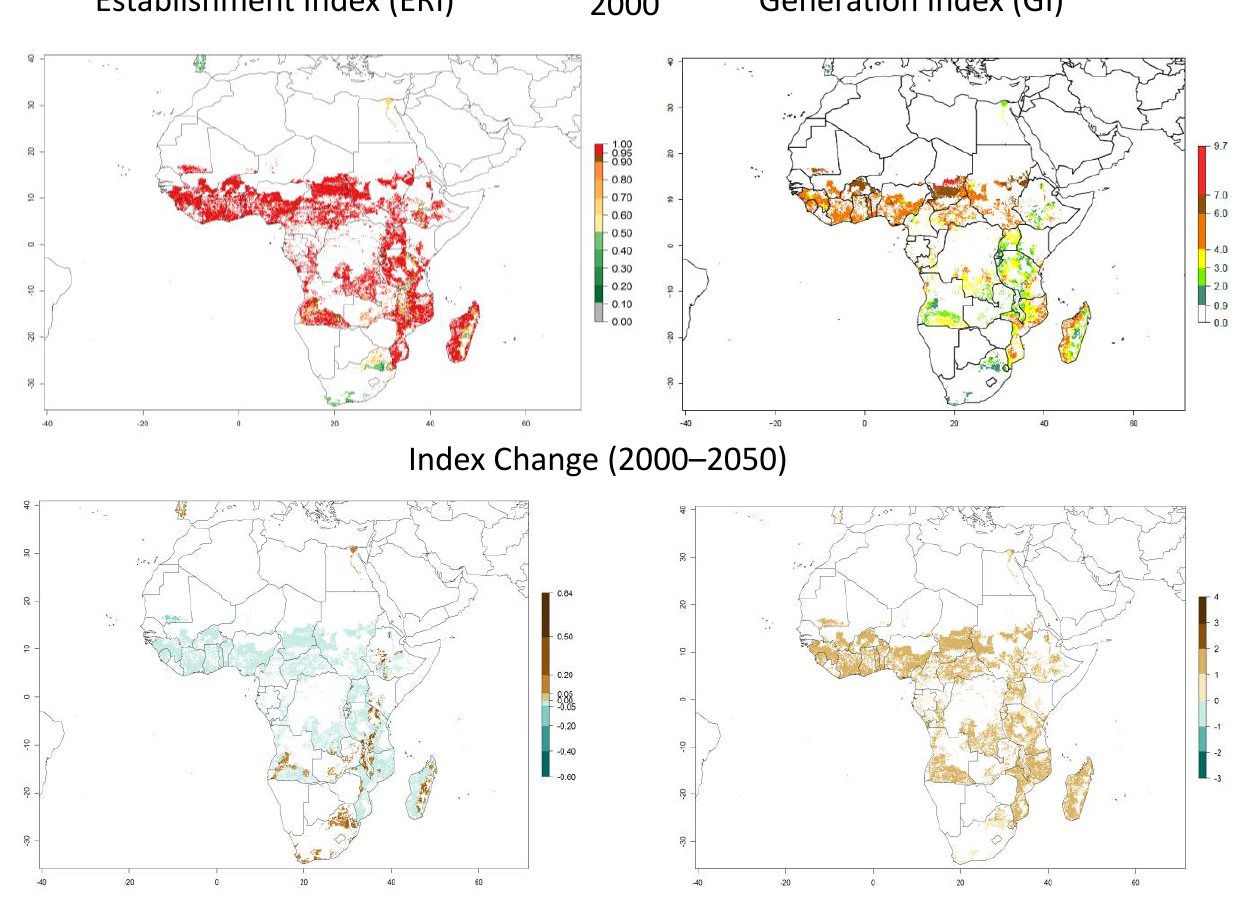
Figure 7: Changes in establishment and potential distribution (ERI) and abundance (GI) of the sweet potato weevil, Cylas puncticollis , in sweet potato production areas of Africa according to model predictions, using the ERI and GI for the years 2000 and changes of the ERI and GI between 2000 and 2050 (Index Change). An ERI>0.95 is associated with potential permanent establishment of the pest (source: Okonya et al. 2016)